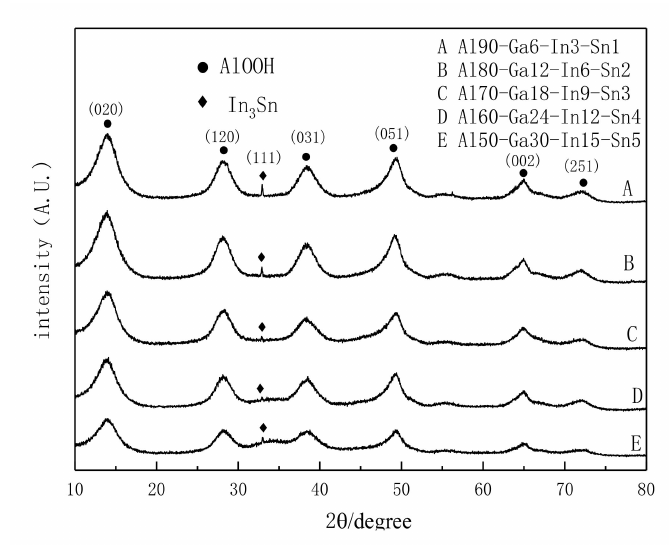
Figure 6. GIS XRD map of hydrolysate at